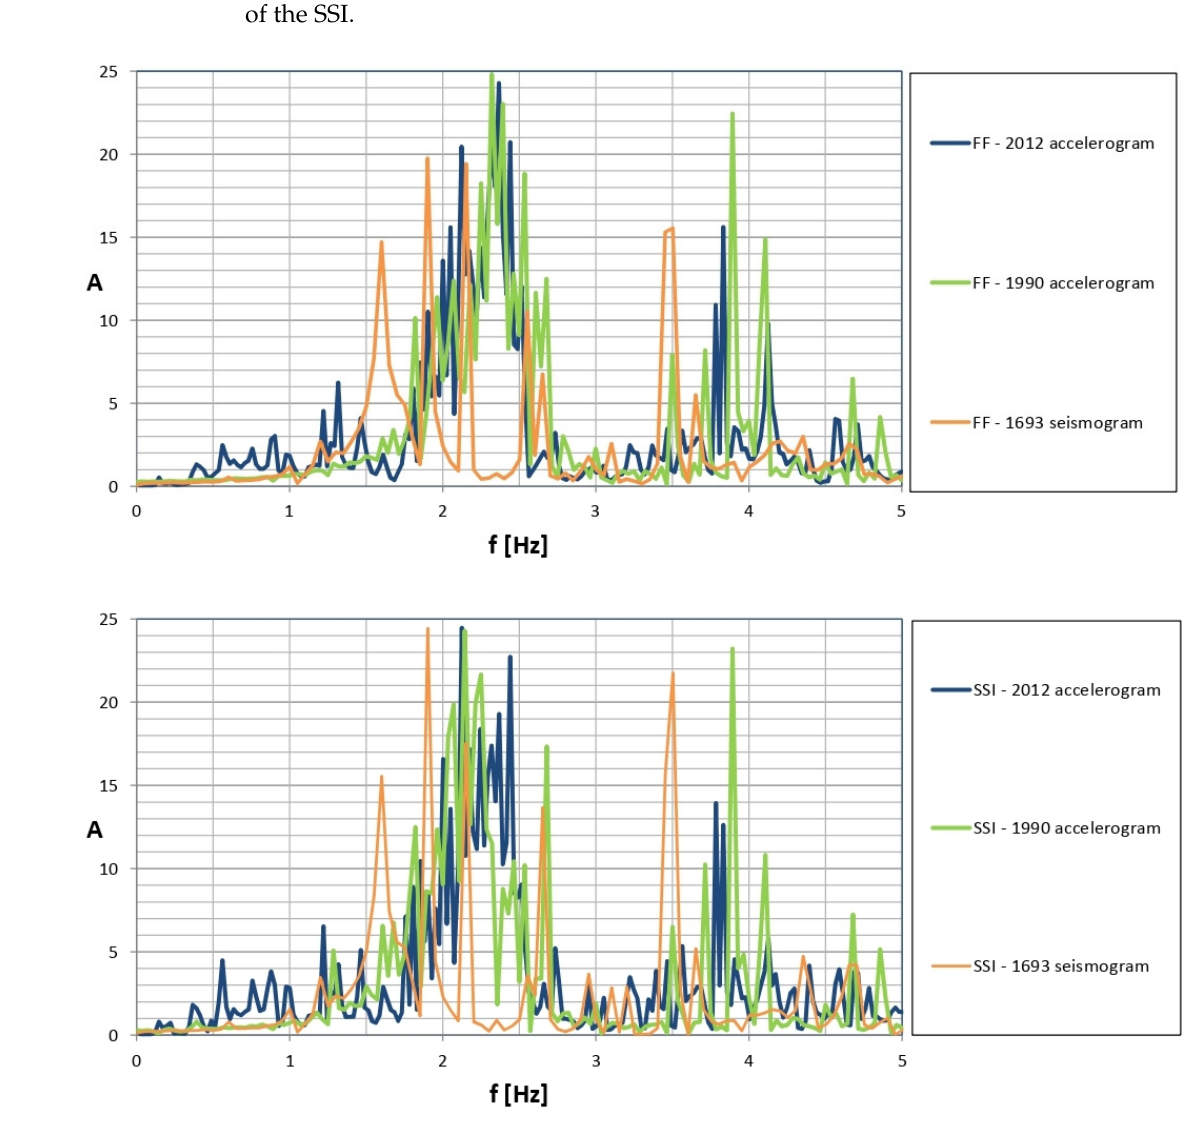
Figure 27. Amplification functions for each seismic input: ( a ) FF alignment, and ( b ) SSI alignments.